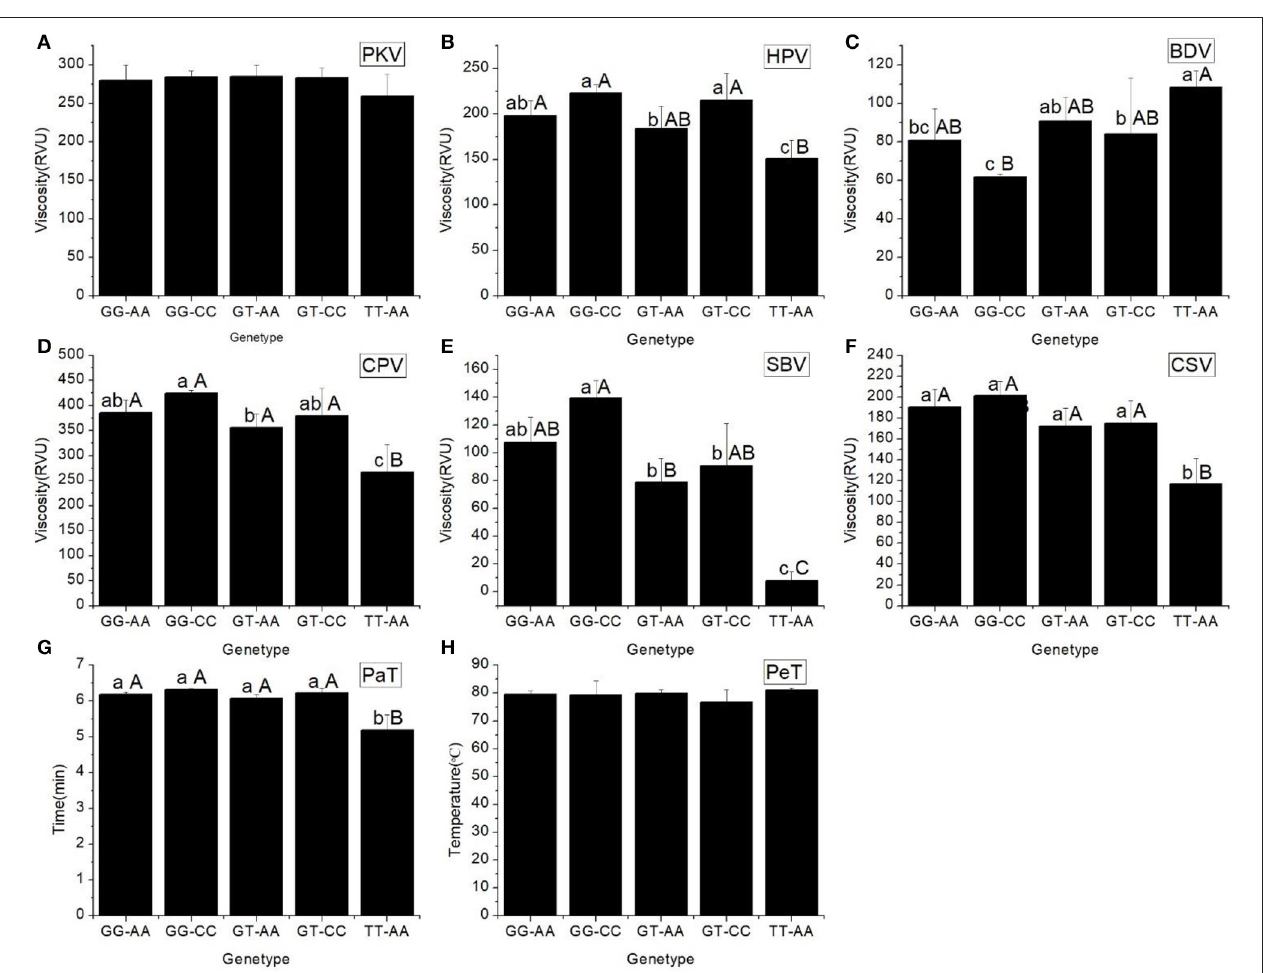
FIGURE 1 | RVA profile characteristics for different haplotypes of In1G/T and Ex6A/C polymorphisms of Wx . (A) Peak viscosity (PKV). (B) Hot paste viscosity (HPV). (C) Cool paste viscosity (CPV). (D) Breakdown valve (BDV). (E) Setback valve (SBV). (F) Consistency valve (CSV). (G) Pasting temperature (PaT). (H) Pasting time (PeT). GG-AA, GG-CC, GT-AA, GT-CC and TT-AA represent different haplotypes of In1G/T and Ex6A/C polymorphisms of Wx . Lowercase and capital letters above column denote significant at 0.05 and 0.01 levels,